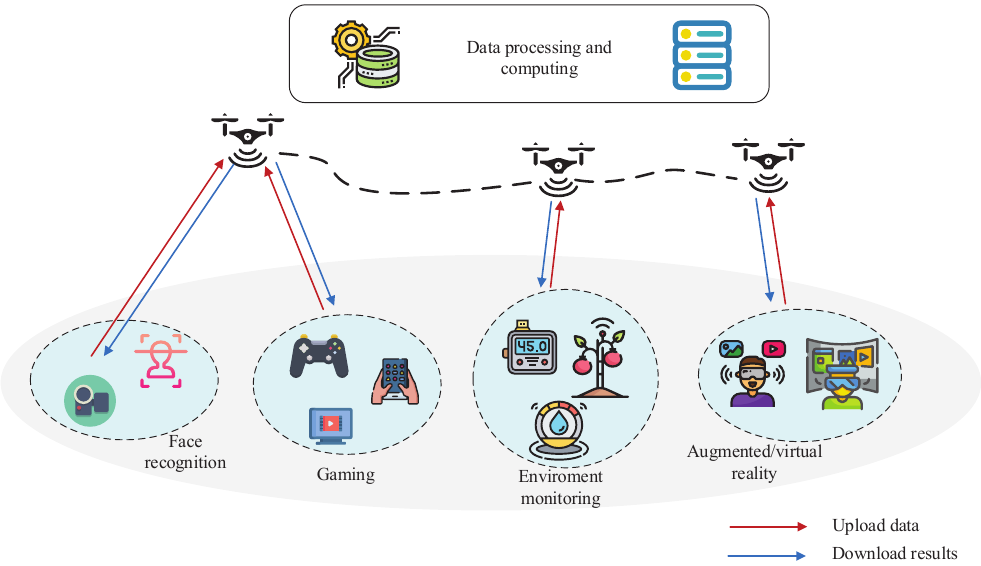
Figure 1. Unmanned aerial vehicles (UAV)-enabled mobile edge computing (MEC)